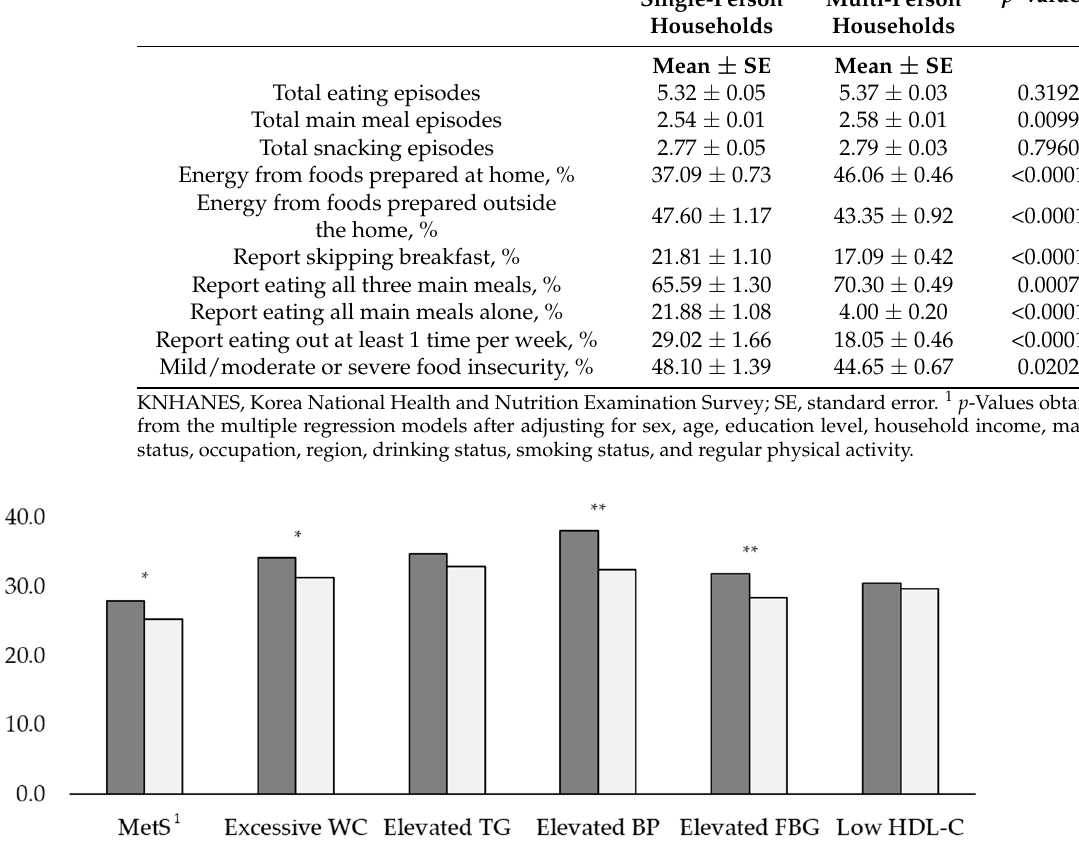
recall, KNHANES 2014–2018.